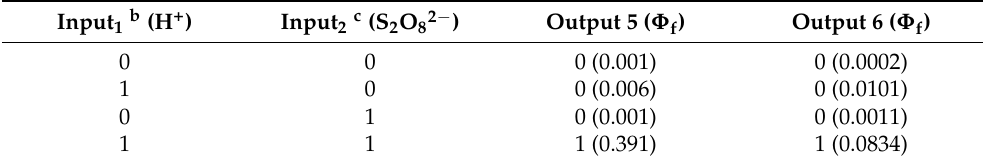
Table 2. Truth tables for 5 in 1:1 ( v / v ) methanol/water and 6 in 1:4 ( v / v ) methanol/water with HCl and APS as inputs and emission as the output a